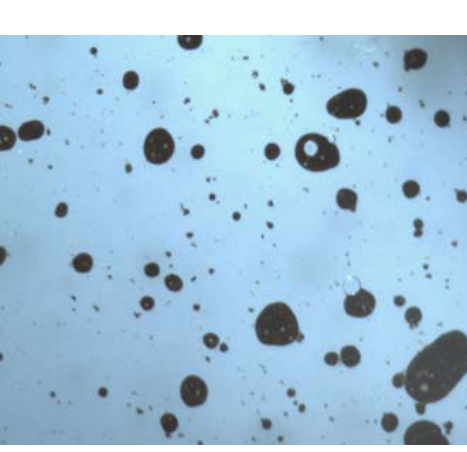
Figure 7. The appearance of the emulsion